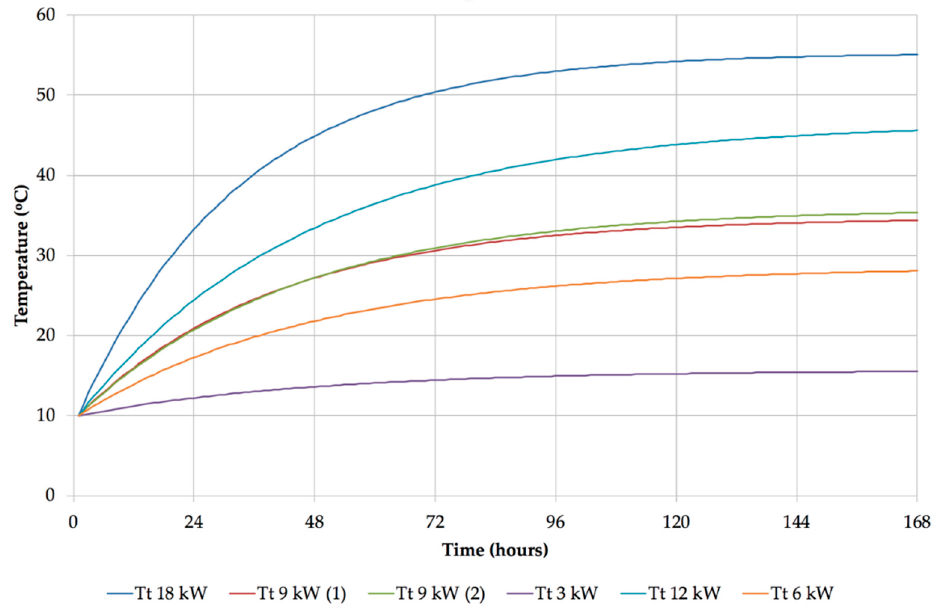
Figure 9. Curves fitted to indoor air temperatures data.